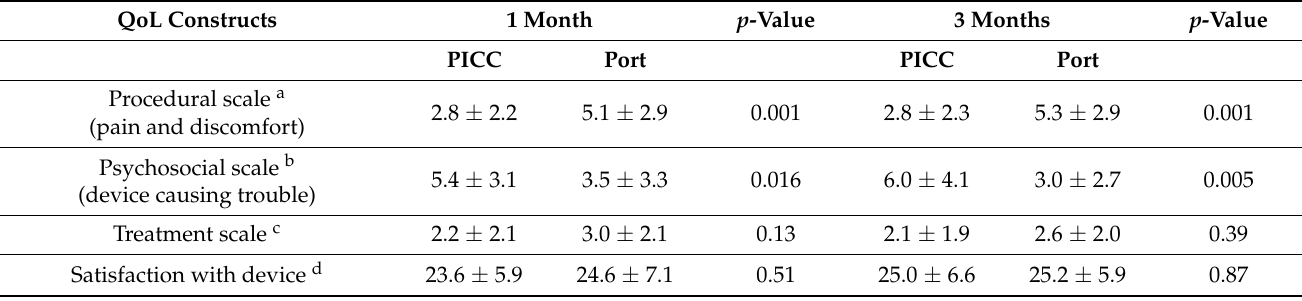
Table 4. Mean QLVAD scale and standard deviation (SD) at baseline and 3 months between the PICC line and the Port groups. QoL